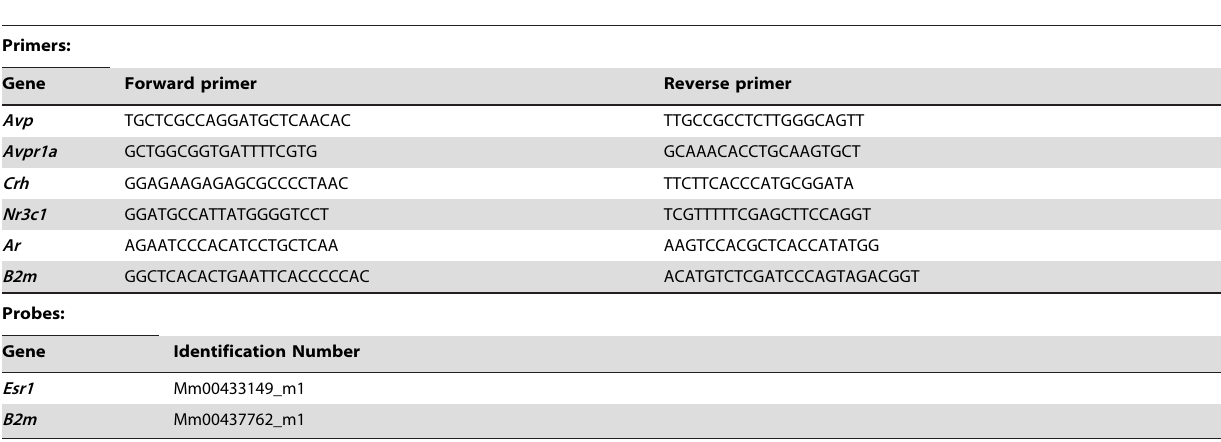
Table 1. List of quantitative PCR primers and Taqman H probes used for gene transcription